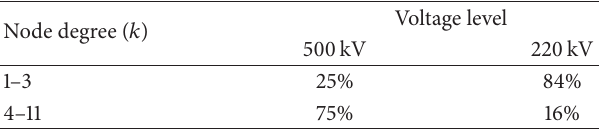
Table 2: Node degree statistics of TJ220